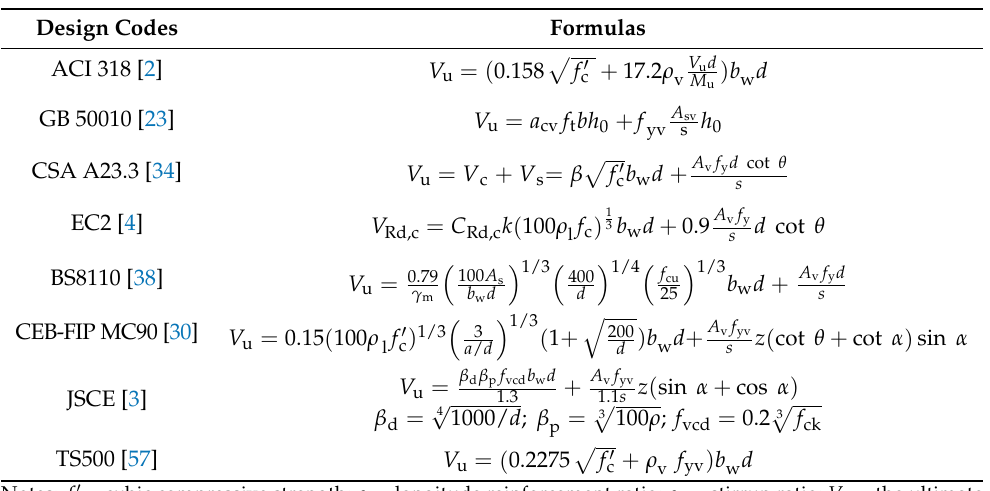
Table A1. National codes for the shear strength of